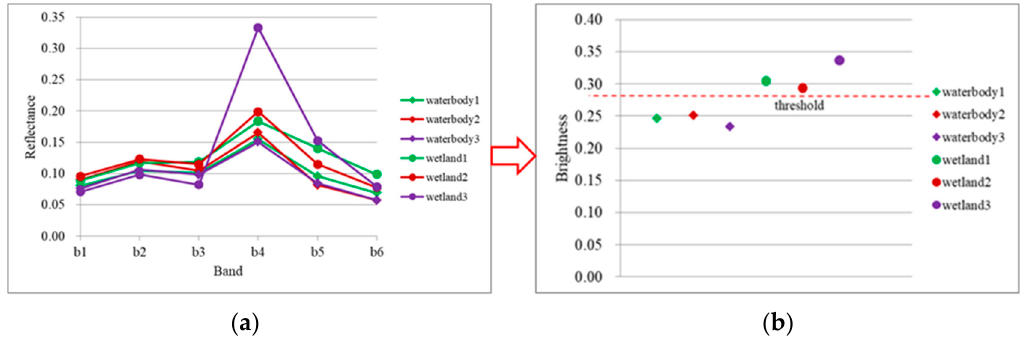
Figure 4. Reflectance and brightness values of water bodies and wetlands. ( a ) the spectral signatures of waterbody and wetland; ( b ) the brightness of waterbody and wetland.